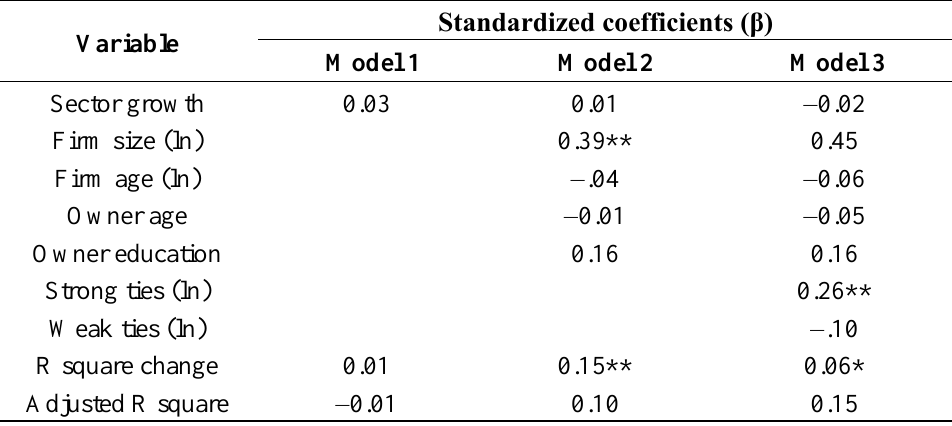
Table 4. Regression analysis of knowledge acquisition and network